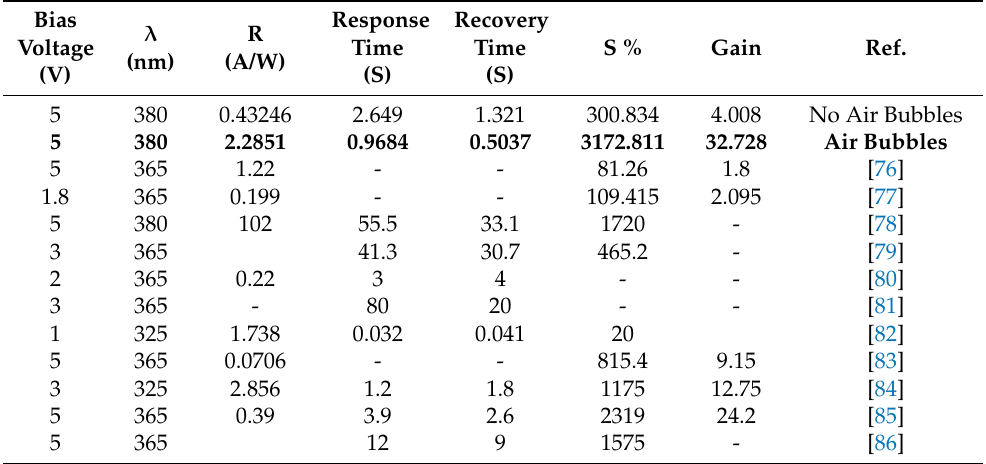
Table 3. Comparison between the current study and the literature of the responsivity (R), response time, recovery time, sensitivity (S), and gain for the (Al/ZnO nanorod) UV photodetectors based on ZnO nanorods fabricated by two ways of